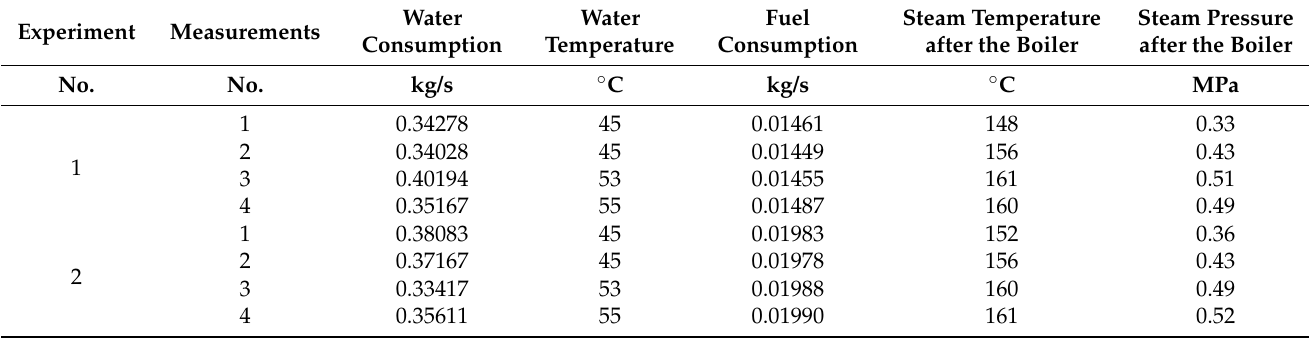
Figure 9. Relationship between parameters in Steam boiler 2: ( a ) relationship between steam temperature and fuel consumption, ( b ) relationship between steam pressure and fuel. The correlation coefficient showing the relationship between steam pressure and fuel consumption of boiler 2 is also 0.89. The above conclusion for the considered rela ‐ tionship between steam temperature and fuel consumption is also accepted for these parameters, Table 4. Mode 2. Simultaneous operation of two boilers with the inclusion of two feed pumps, Table 5. Table 4. Experimental values of Steam boiler 2. Table 5. Experimental values of two steam boilers in mode